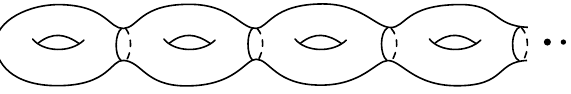
Figure 1: The Infinite Loch Ness